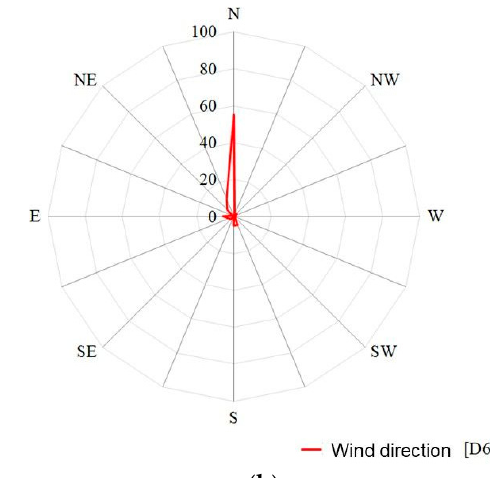
Figure 7. Outside air temperature.